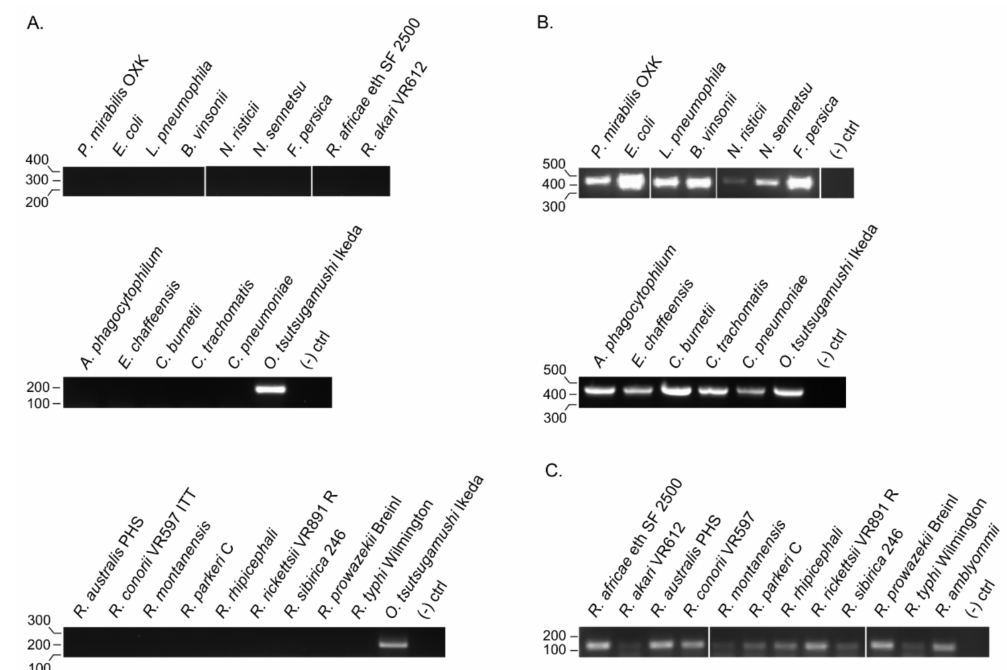
Figure 7. Confirmation of ompA -57F/260R specificity. DNA samples from eubacterial and Rickettsia spp. were subjected to PCR using ( A ) ompA -57F/260R. The eubacterial and Rickettsia spp. DNA samples were also subjected to PCR using primer sets targeting eubacterial 16S rRNA ( B ) and the rickettsial gene encoding the 17-kDa protein ( C ) to verify sample integrity. For the experiment in (A), O. tsutsugamushi Ikeda DNA was included as a positive control. A minus template control (( − ) ctrl) was included in each experiment. Vertical lines between lanes indicate that irrelevant lanes from the gel images were removed. Data are representative of two experiments with similar